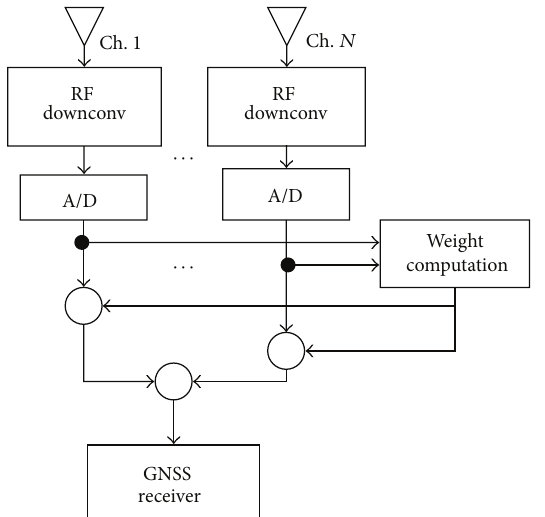
Figure 1: Single-output nulling antenna block diagram.